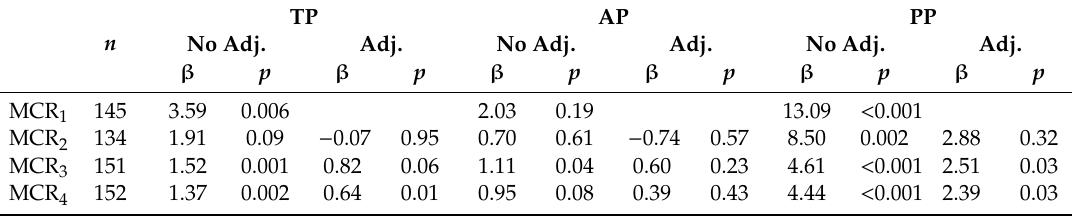
Table 2. Regression Analyses Comparing MCR Equations and Protein